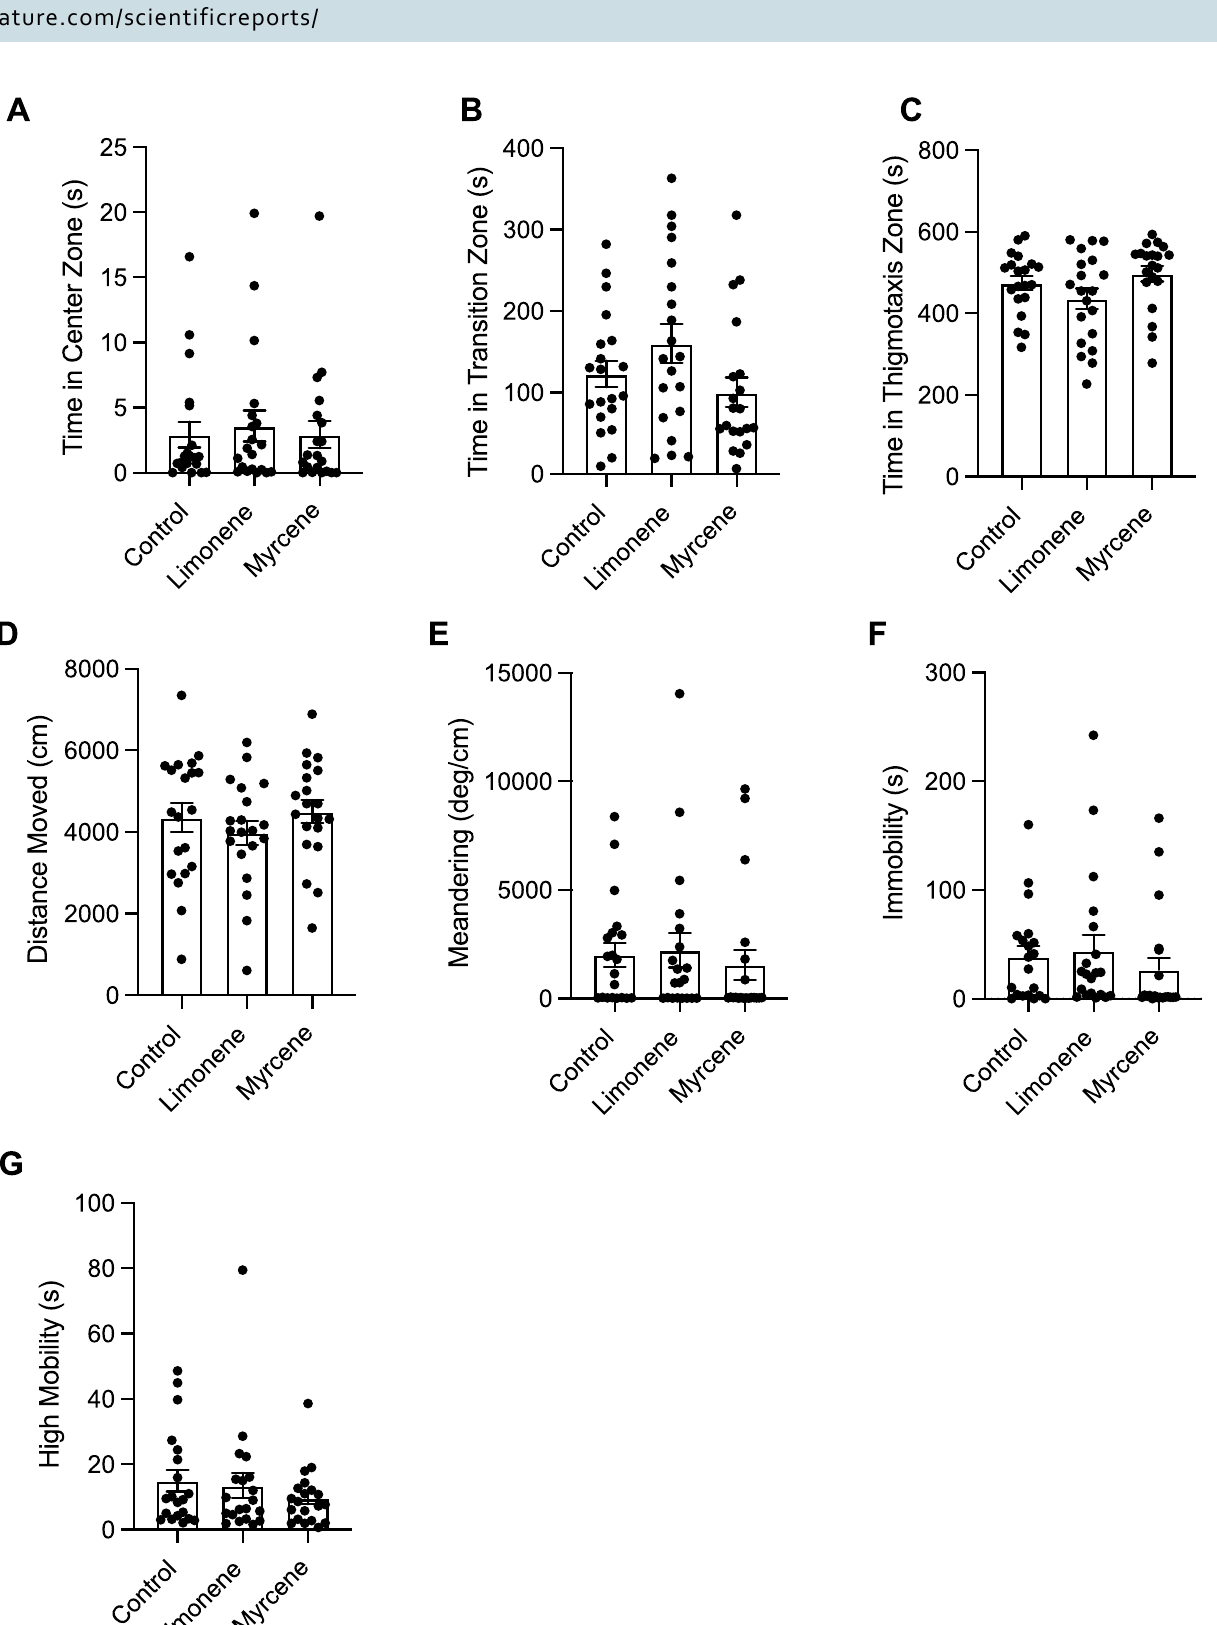
Figure 8. The effects of repeated terpene administration (limonene or β-myrcene) on zebrafish behaviour assessed by the novel object approach test. Average time spent in the center ( A ), transition ( B ), and thigmotaxis ( C ) zone during the novel object approach test. Fish locomotion was quantified in the novel object approach test by measuring distance moved ( D ), meandering ( E ), time spent immobile ( F ), and time spent highly mobile ( G ). All data are presented as mean ± S.E.M. No significant differences were observed between control and terpene treated